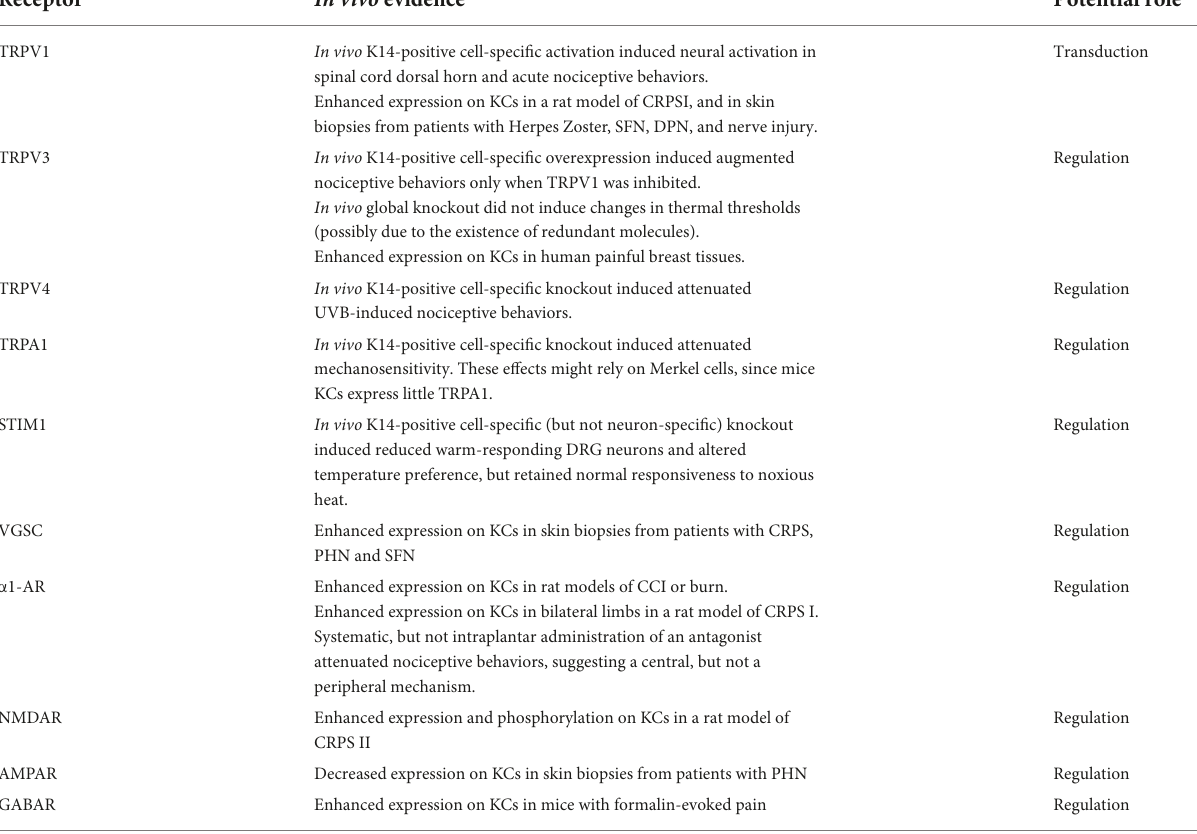
TABLE 1 Summary of in vivo evidence on the roles of sensory and neurotransmitter receptors expressed on keratinocytes in nociceptive transduction and regulation. Receptor In vivo